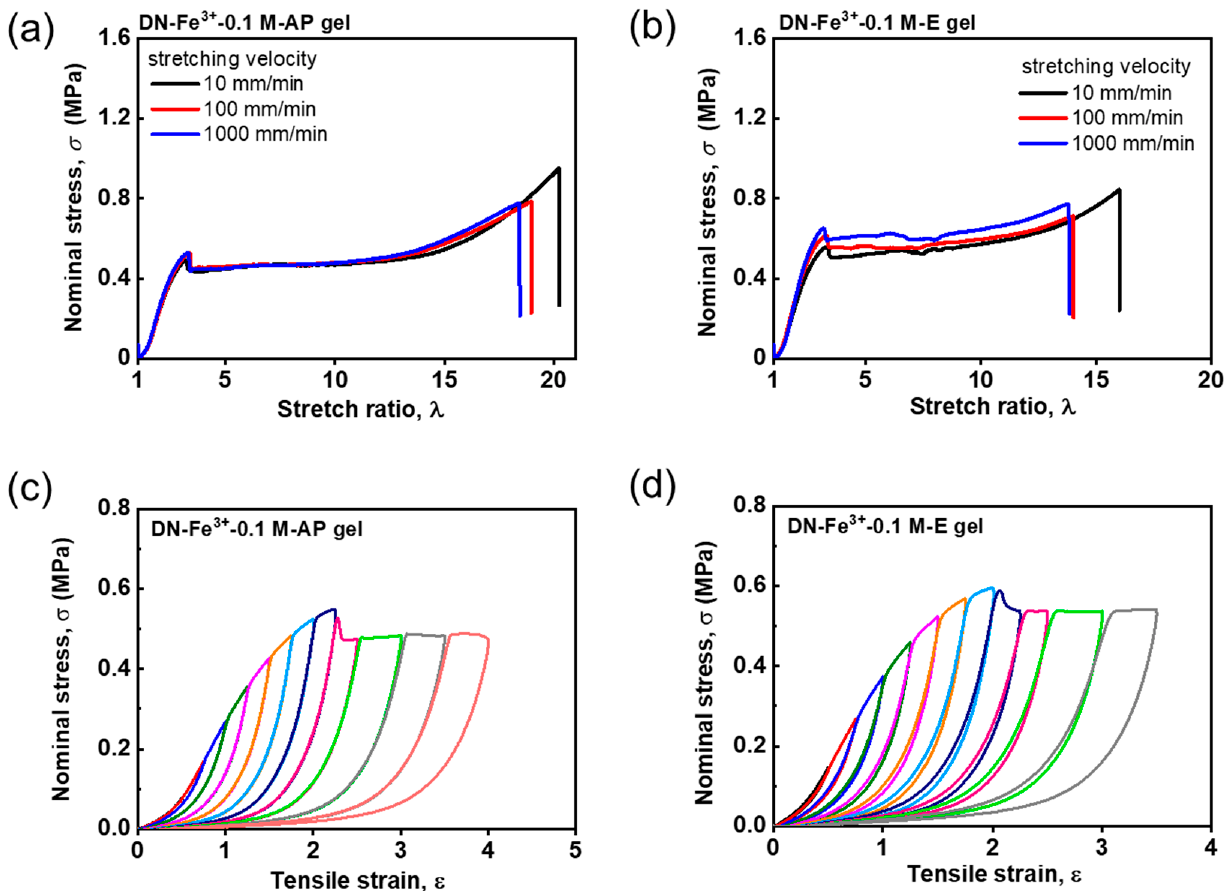
Figure 6. Tensile behaviors and cyclic tensile behaviors for various DN hydrogels coordinated with Fe 3+ ions. ( a , b ) Rate-independent tensile behaviors of the DN − Fe 3+ − 0.1 M − AP ( a ) and rate-dependent tensile behaviors of the DN − Fe 3+ − 0.1 M − E ( b ) hydrogels under different deformation rates ranging from 10 to 1000 mm/min. ( c , d ) Sequential loading–unloading cycles for the DN − Fe 3+ − 0.1 M − AP hydrogels ( c ) and DN − Fe 3+ − 0.1 M − E hydrogels ( d ) at a deformation rate of 100 mm/min. The rate-independent elastic DN − Fe 3+ − 0.1 M − AP hydrogels show irreversible hysteresis, while the rate-dependent viscoelastic DN − Fe 3+ − 0.1 M − E hydrogels show partially reversible hysteresis owing to the metal coordination interactions.